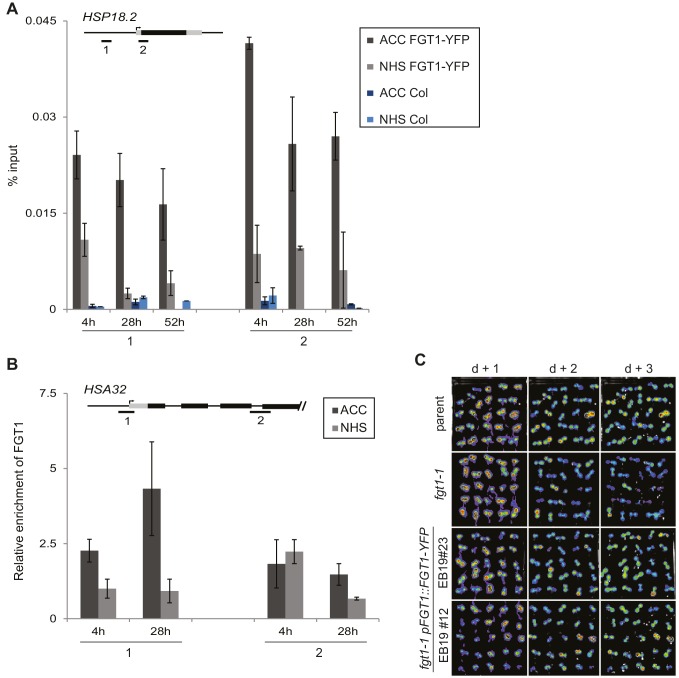
FGT1-YFP expressed from the endogenous promoter binds to HSA32.(A) FGT1-YFP derived from 35S::FGT1-YFP binds the HSP18.2 locus already before HS as determined by ChIP-qPCR on 35S::FGT1-YFP or Col-0 seedlings. 4 d-old seedlings were subjected to an acclimatizing HS (ACC), or no HS (NHS). ChIP-qPCR was performed at the indicated times after the treatments. Schematic shows positions of regions analyzed. Data show one representative experiment. Error bars are SD of three technical replicates. (B) FGT1-YFP expressed from the FGT1 promoter binds to HSA32 as determined by ChIP-qPCR. FGT1 enrichment around the TSS of HSA32 (region 1) increases after ACC and remains elevated for at least 28 h. Amplification values were normalized to input and the region 2 at 28 h NHS. Error bars are SE of two biological replicates. (C) The pFGT1::FGT1-YFP transgene complements the HSA32-LUC phenotype of fgt1-1. HSA32::LUC-derived bioluminescence of the indicated genotypes was assayed 1, 2, or 3 d after an acclimatizing HS. Blue indicates low LUC activity, red indicates high activity (cf. Figure 1A). The signal threshold was adjusted to the signal of the parental line.